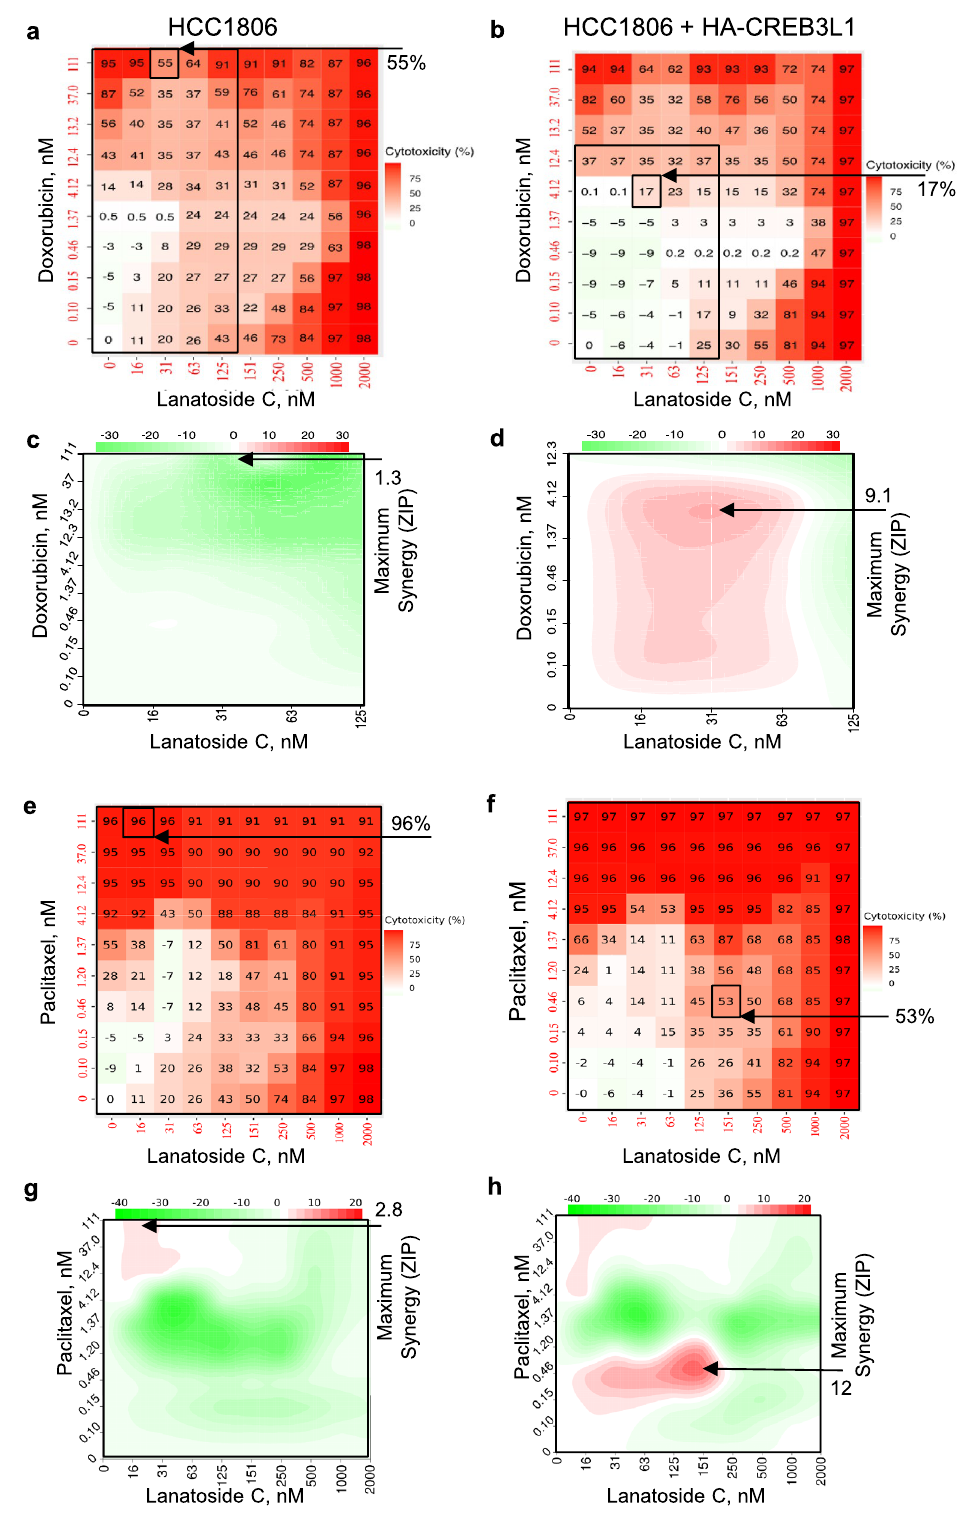
Figure 6. Assessing possible drug synergy between lanatoside C and either doxorubicin ( a-d ) or paclitaxel ( e– h ). Cell viability ( a, b, e, f ) was measured after 4 days of drug treatment over a range of drug concentrations for HCC1806 ( a, c, e, g ) and HCC1806 + HA-CREB3L1 ( b, d, f, h ) cells. Lanatoside C EC 50 for HCC1806 = 143 nM; 1:2 serial dilutions (0–2 mM). Doxorubicin EC 50 for HCC1806 = 13 nM; 1:3 serial dilutions (0–111 nM). Paclitaxel EC 50 for HCC1806 = 1.2 nM; 1:3 serial dilutions (0–111 nM). A zero-interaction potency score (ZIP; c, d, g, h ) was calculated by the SynergyFinder R-package for each data point to measure possible drug synergy; ZIP > 10 indicates